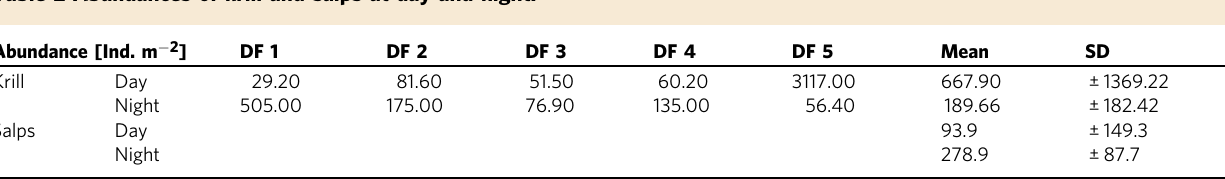
Abundances are shown for each of the fi ve drifting trap deployments (DF 1 – 5), as well as a mean across all traps with standard deviation (SD). Salp ( Salpa thompsoni ) abundances are based on quantitativeobliquenettowsandintegratedover170m.Krill( Euphausiasuperba )abundancesarebasedonthehydroacousticsurveyintegratedoverthetop200m.Dayandnightwerede fi nedaccording to the local time of sunrise and sunset as the periods from 06:00 am to 19:00pm, and from 19:00p.m. to 06:00a.m., respectively (UTC – 03:00).